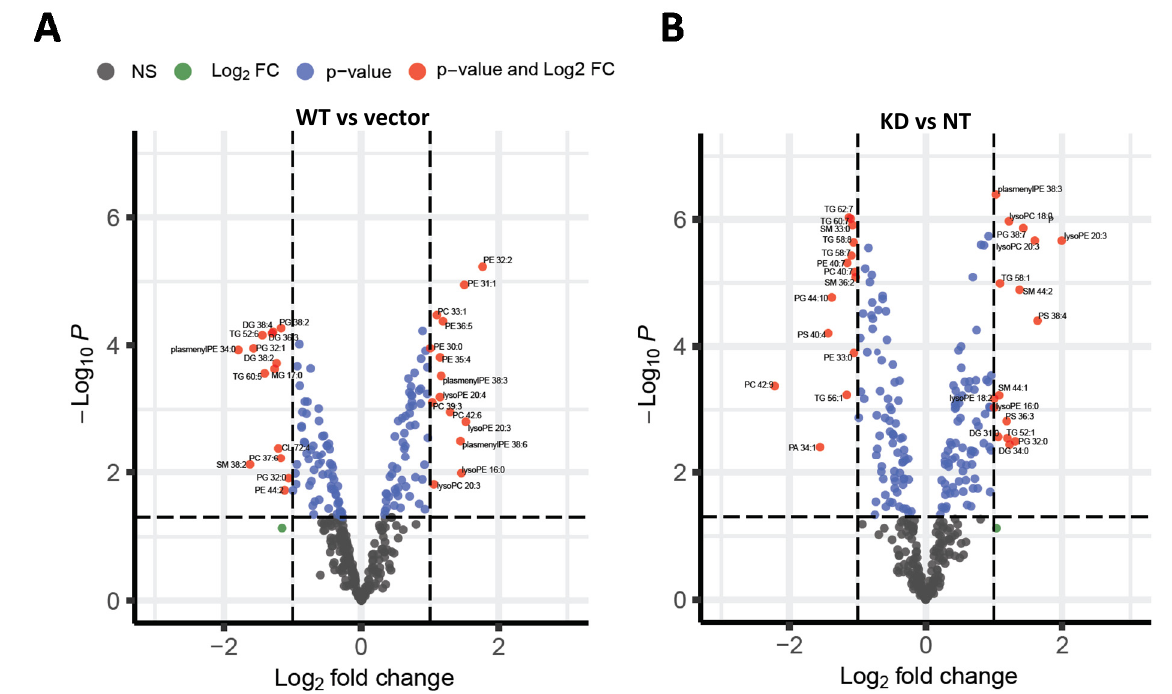
Figure 2. Effects of TM6SF2 on hepatic lipid profile . Volcano plots showing relative abundance of lipid species identified through untargeted lipidomic analysis. X -axis is the log 2 fold change of lipid species abundance in Huh-7 cells for ( A ) wild-type TM6SF2 overexpression compared to vector control ( B ) TM6SF2 knockdown compared to non-targeting control. For both ( A , B ), Y -axis represents the adjusted p value. Negative values indicate downregulated lipids, while positive values upregulated lipids in the overexpression or knockdown cells compared to their respective controls. Vertical dotted lines represent the threshold for log 2 fold change (>1 or < − 1) and horizontal dotted line represent the threshold for adjusted p value (Bonferroni corrected; p < 0.05). Only the lipid species that met the threshold criteria for both p -value and log fold change are labelled (red dots). Values for log fold change and significance for lipids that meet both threshold are shown in detail in Supplementary Table S1. Wild-type TM6SF2 (WT), pCMV empty vector control (Vector), non-targeted shRNA control (NT), and TM6SF2 knockdown (KD).